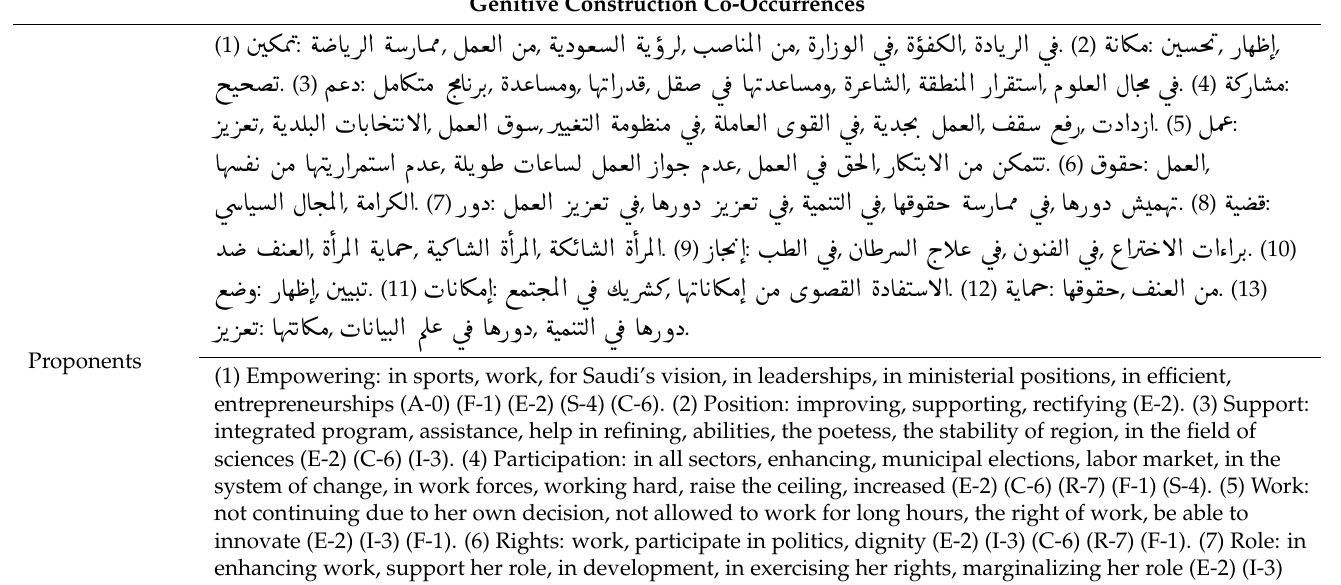
Table 12. Broad contexts of the genitive construction co-occurrences ( rf = >0.00001 × 100). Genitive Construction Co-Occurrences